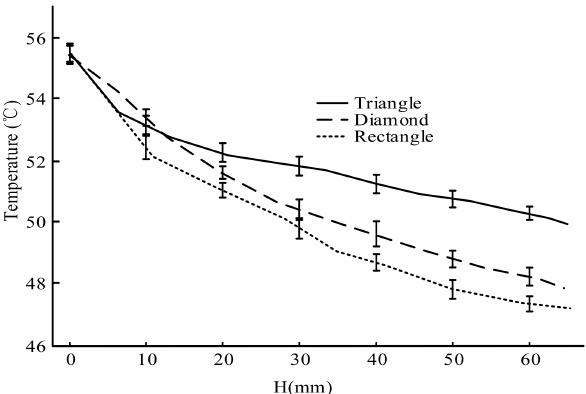
Figure 9. Temperature in the convective heat-exchange area of the diamond, triangle and rectangle lithium-ion battery packs when the discharging is completed.